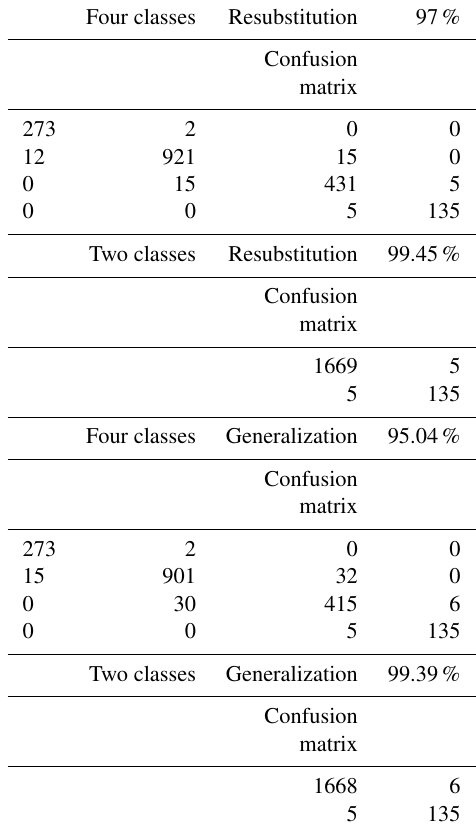
Table 2. Classification results for BME680 data using the hold-out approach for the 8 July to 19 September campaign for the period between 12:00 and 13:00CET.